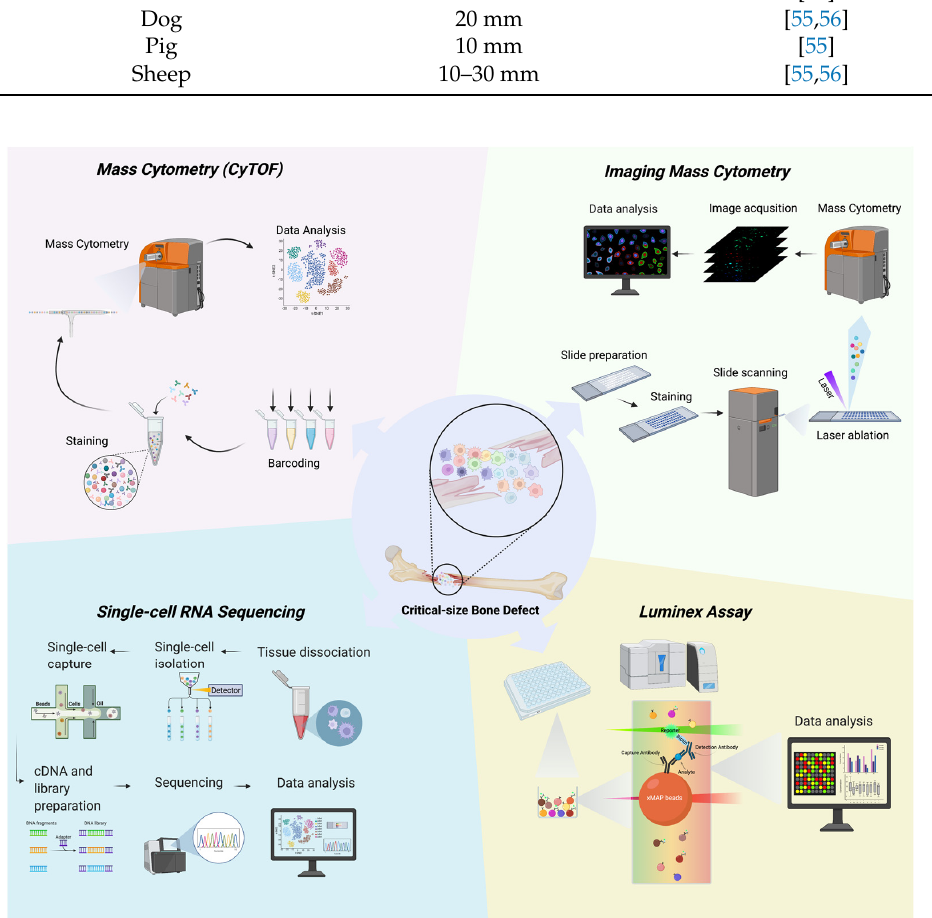
Figure 1. Novel techniques for investigating critical-size bone defects. Small animal models (mice, rats, and rabbits) are commonly used for fundamental studies or screening experiments because of the lower cost and greater ethical acceptance. In addition, immunodeficient mice and rats have been used when researchers